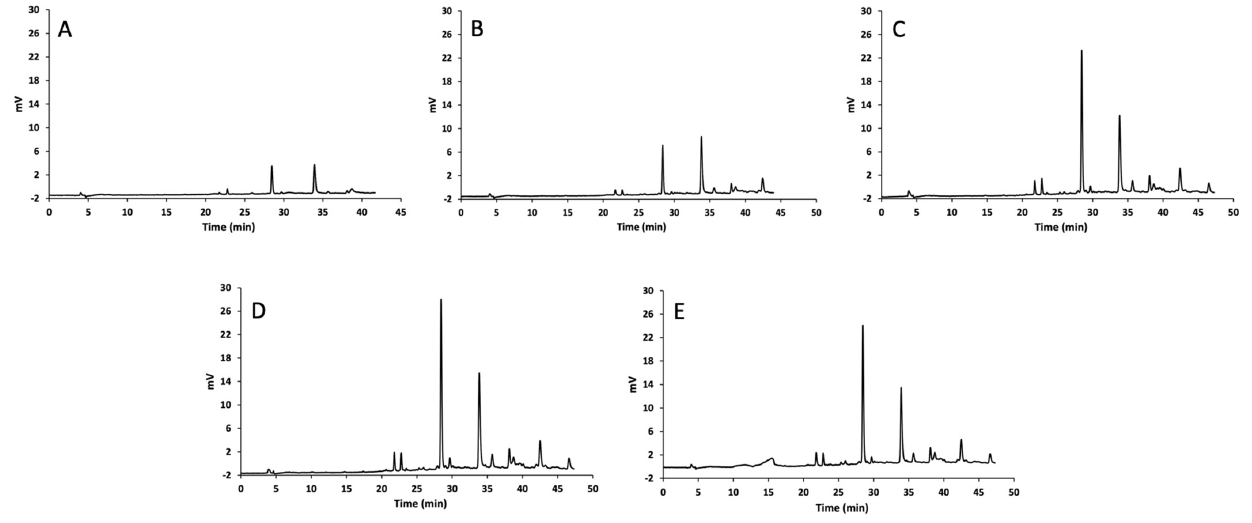
Figure 3. Chromatograms of the HPLC-UV-Vis analysis on onion extracts at 360 nm. ( A ): pure MeOH, ( B ): MeOH 30% w / w water, ( C ): GA/TMG +30% w / w water, ( D ): GA/L-Pro + 30% w / w water, ( E ): pTSA/BZA + 30% w / w water.